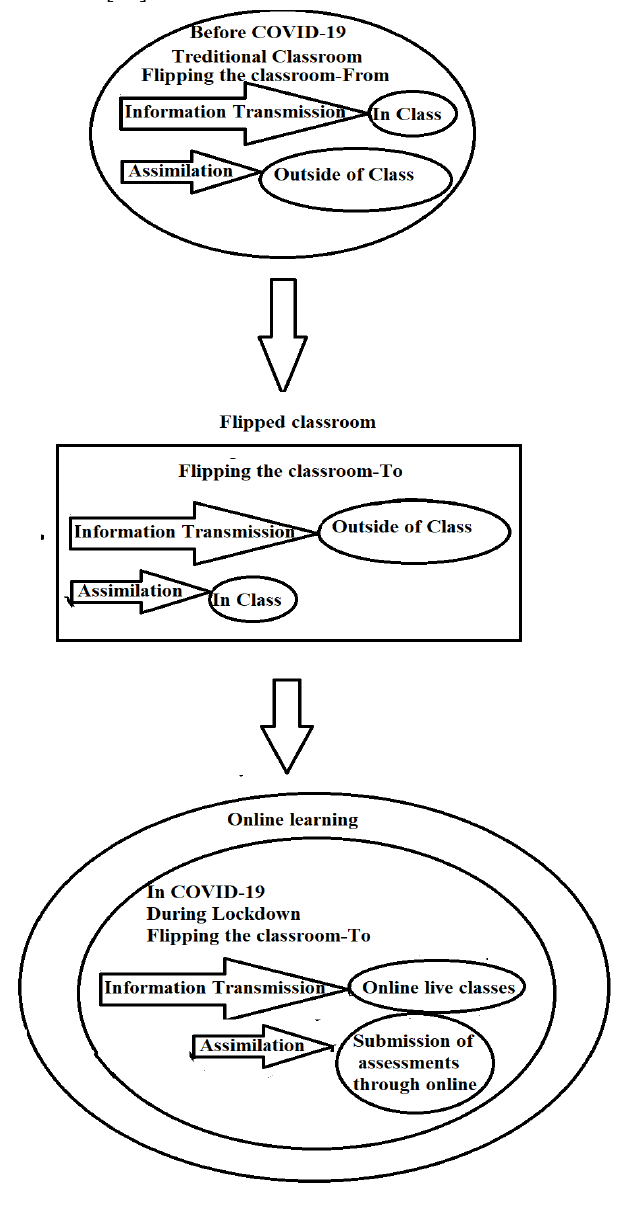
Figure 2. Demand of Computer